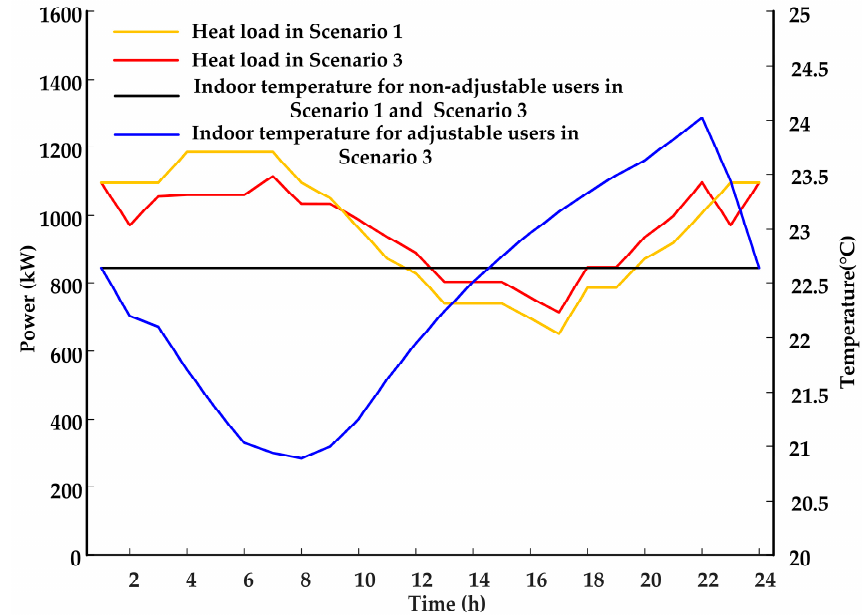
Figure 8. Heat load and indoor temperature in Scenarios 1 and 3.